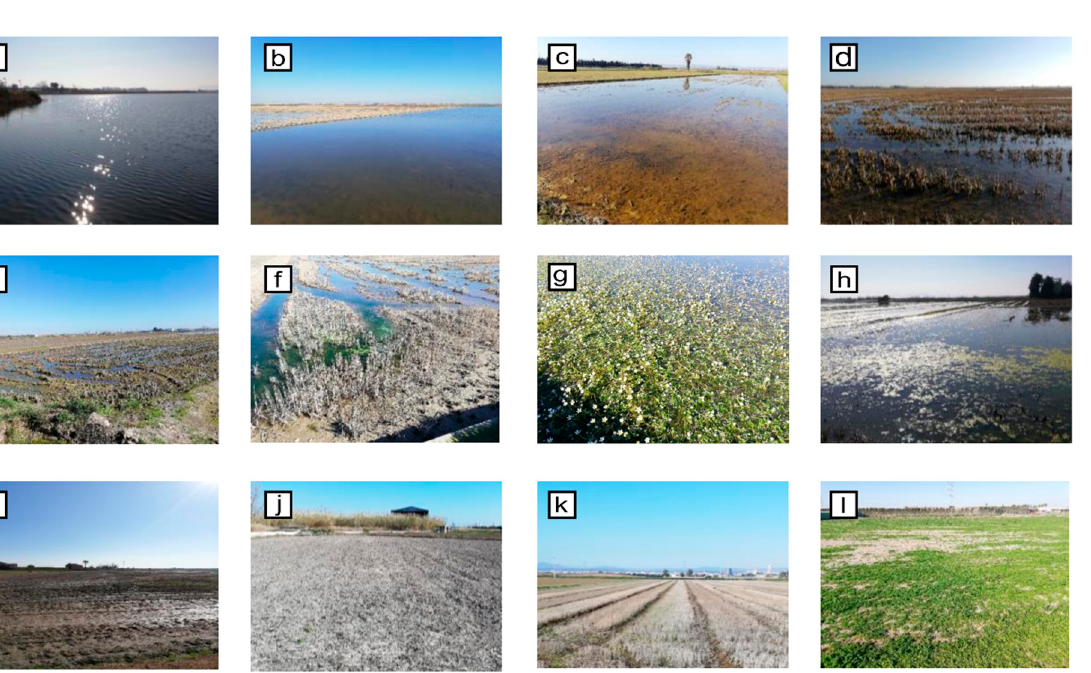
Figure 3. Photographs of land cover classes taken in the Albufera wetland on 14 February 2020; ( a , b ) water; ( c ) shallow turbid water; ( d ) shallow water with dead vegetation; ( e , f ) mosaic of water ponds, mud and vegetation; ( g , h ) flooded area partially covered by vegetation; ( i ) wet soil; ( j ) dry soil; ( k , l ) vegetated soil. Table 3. Rule-based classification method for the mapping of the four land cover classes.